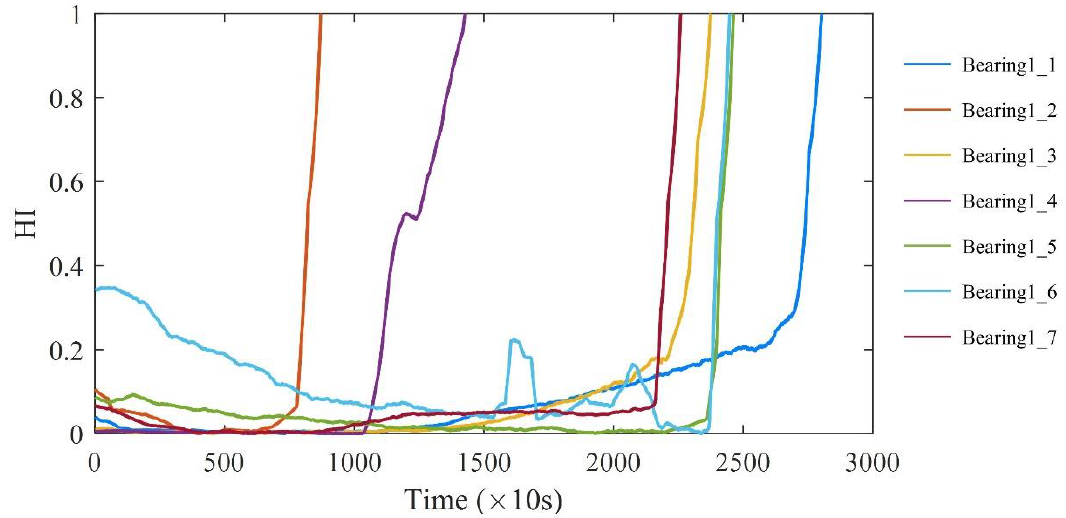
Figure 9. HI curves of the 7 bearings.